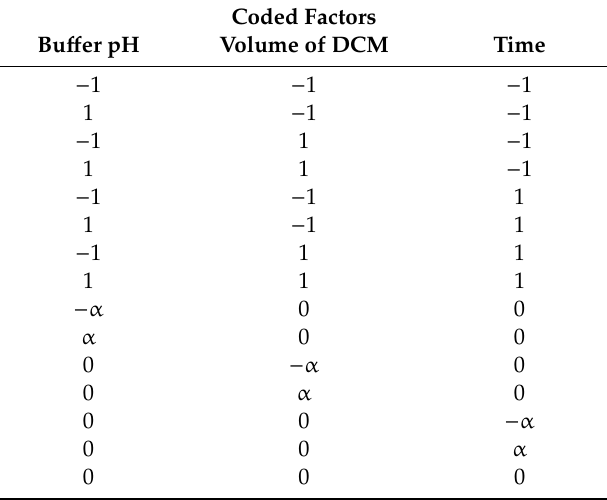
Table 1. The Central Composite Design.